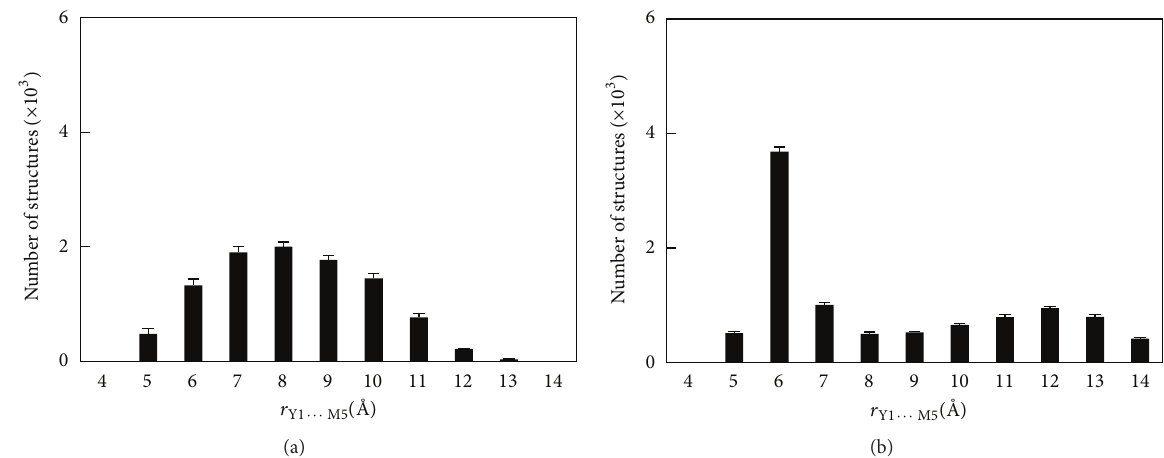
Figure 3: Histograms of the distance between C 𝛼 atoms of Tyr1 and Met5 for 10,000 structures of Met-enkephalin obtained by the SAAP-MC (a) and AMBER-MD (b) simulations at 300 K in water. The results from ten trajectories were averaged. See the text for details of simulation